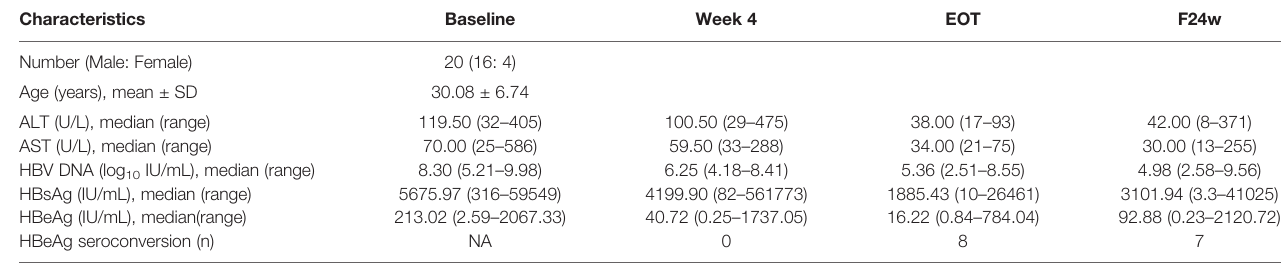
TABLE 1 | Characteristics of patients with chronic HBV infection.